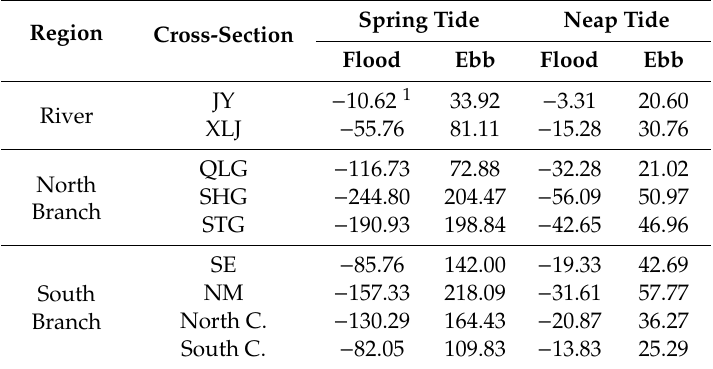
Table 3. Cross-sectional sediment fluxes ( CSSF ) at tide stations (unit: × 10 4 t / day). Region Cross-Section